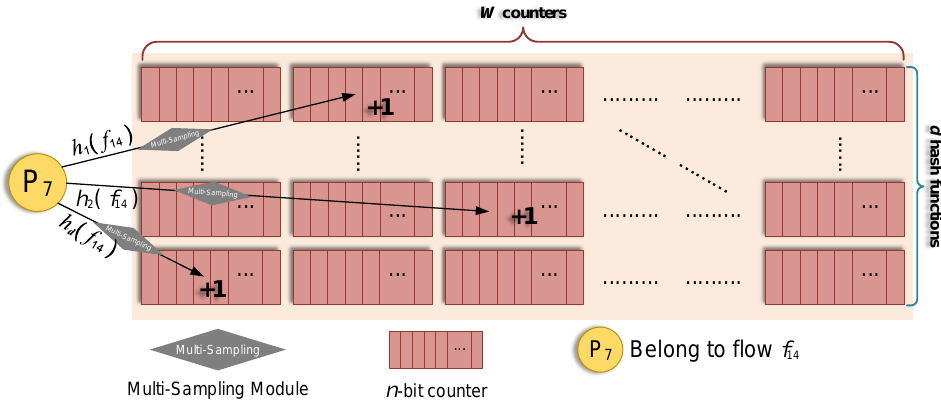
Figure 5. The structure of the lightweight counting module in